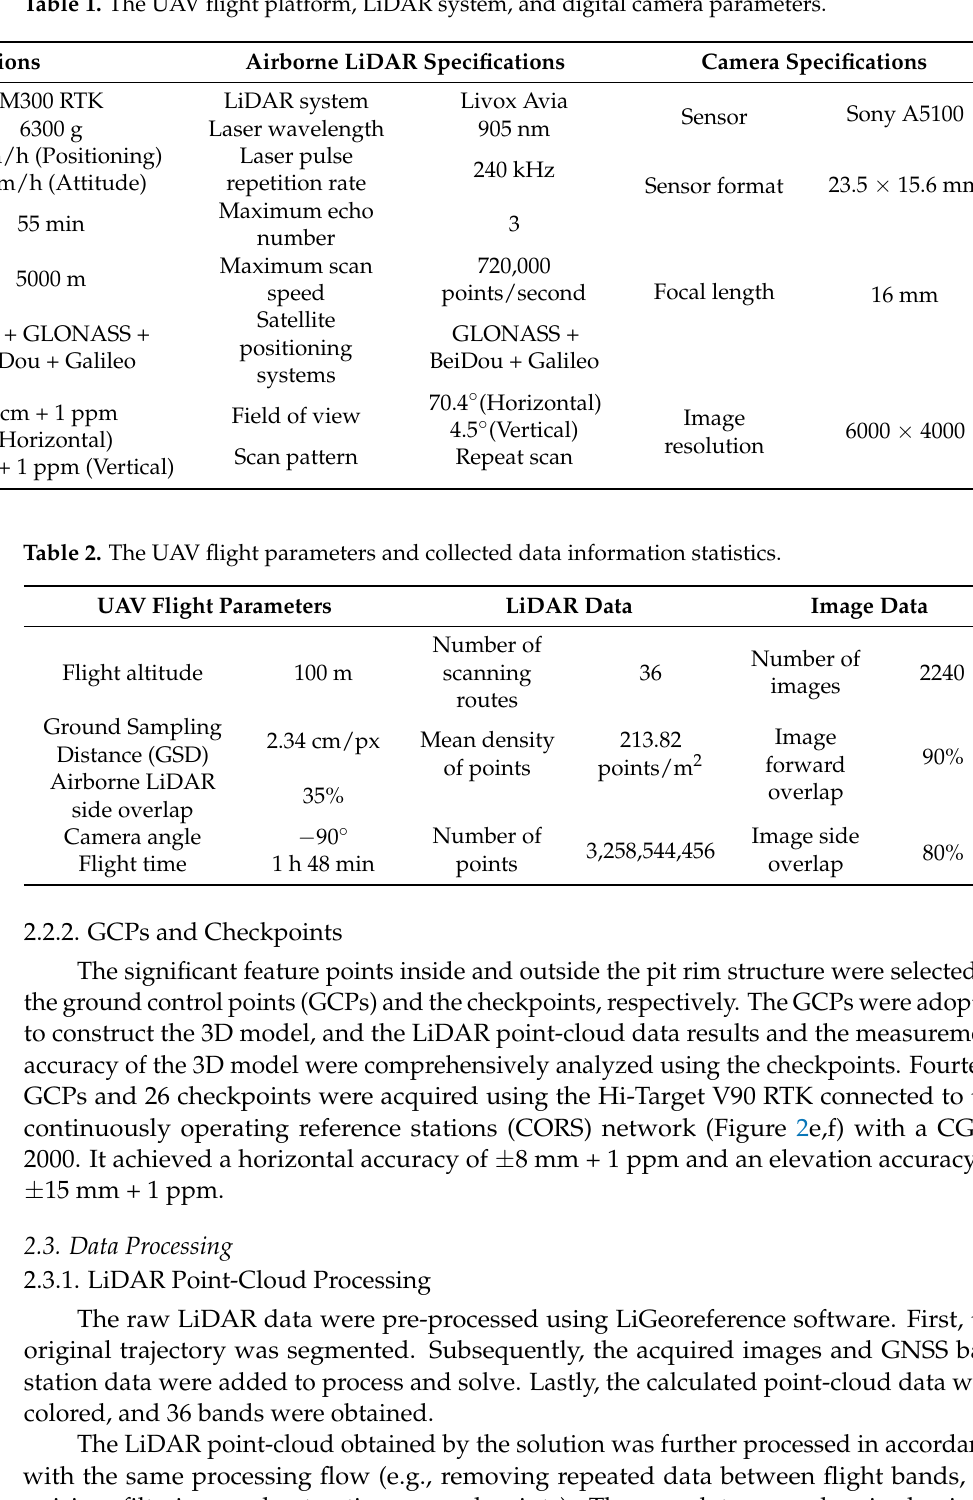
Table 1. The UAV flight platform, LiDAR system, and digital camera parameters.